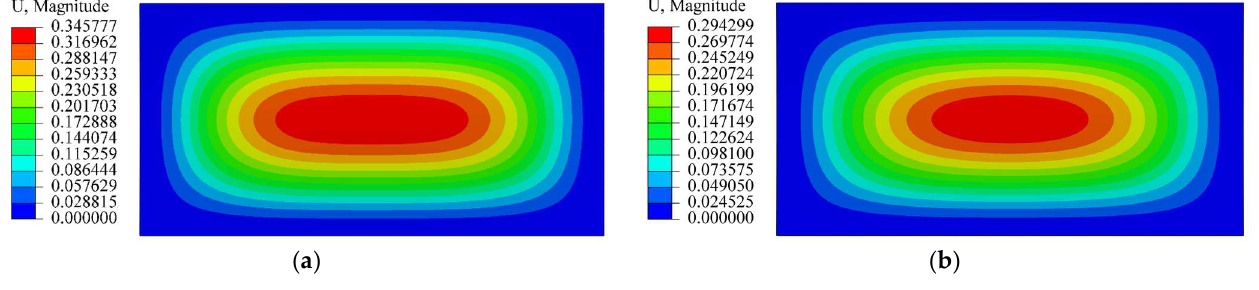
Figure 8. Displacement nephogram when Ra 2 / t = 1/2 and q = 20 Kpa. ( a ) E + / E − = 1; ( b ) E + / E − = 2/3.